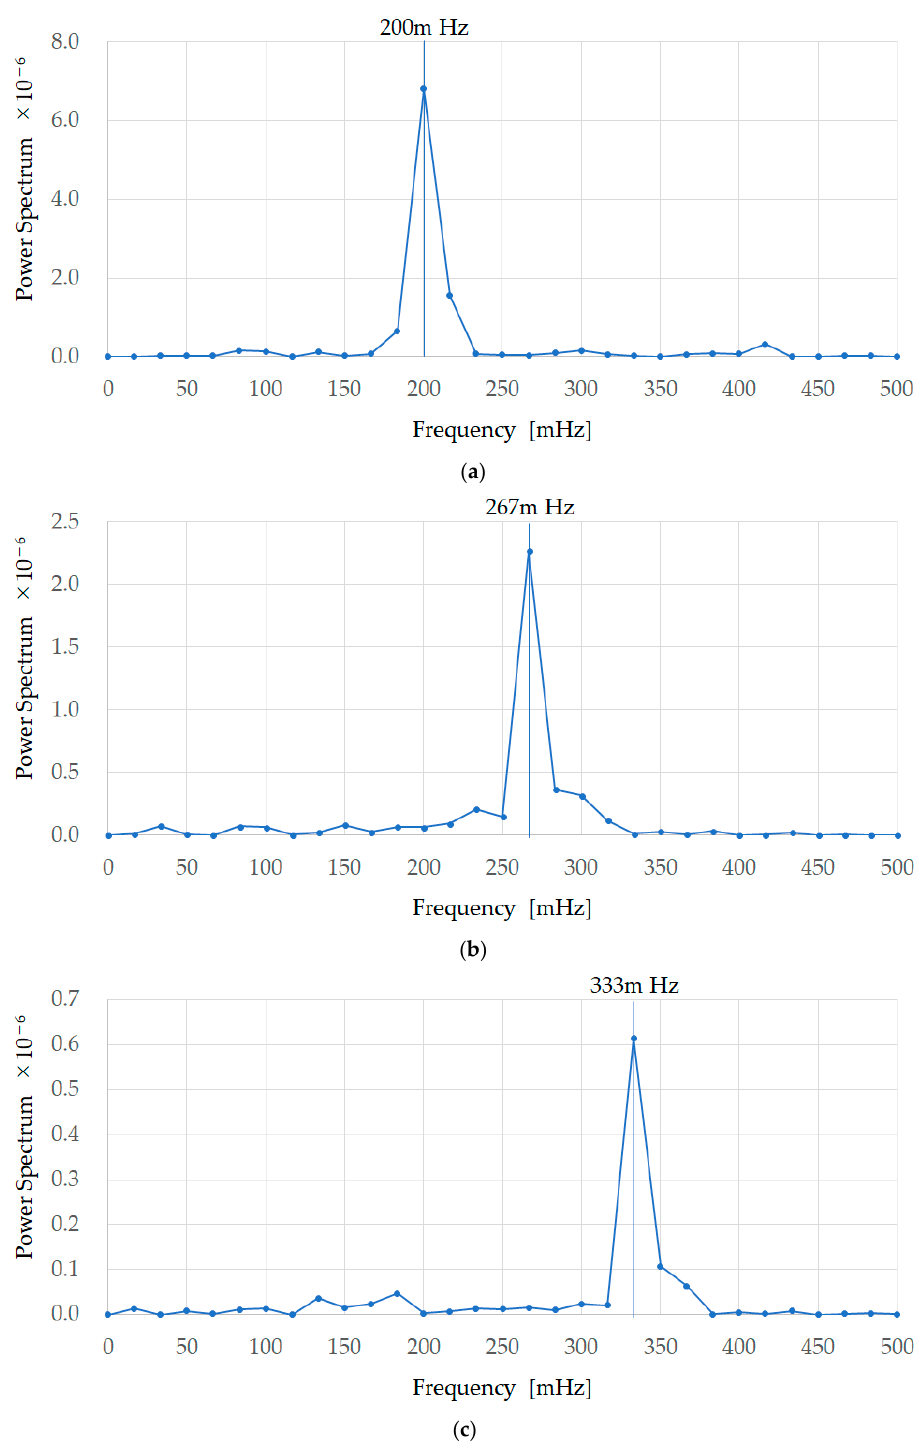
Figure 6. FFT processing results for the experiment results of EX200mHz12rpm, EX267mHz16rpm, and EX333mHz20rpm for subject A. These are the results of performing FFT with a data length of 128 on the data in Figure 5, and show that the true values (timing instruction LED frequencies) and earable POCER calculated values (frequencies at which the power spectrum is maximum) match. ( a ) The first experiment results of 200 mHz (EX200mHz12rpm); ( b ) the first experiment results of 267 mHz (EX267mHz16rpm); ( c ) the first experiment results of 333 mHz (EX333mHz20rpm).